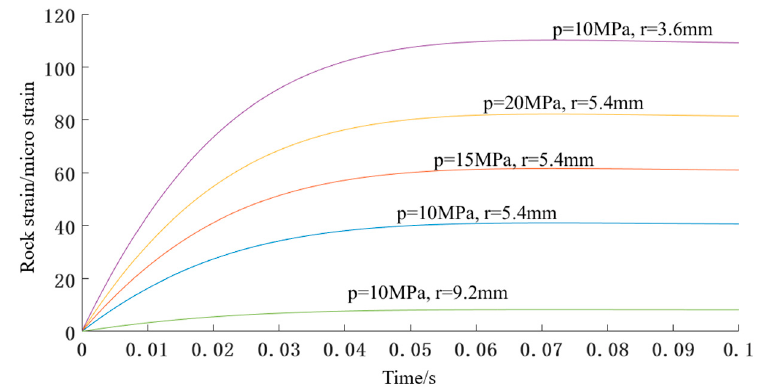
Figure 9. Numerical solutions for the formula for stress wave transmission in rock.